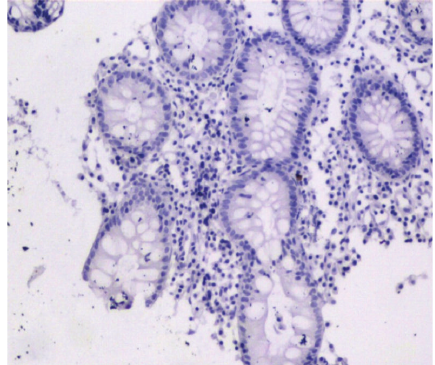
Figure 3: No positive particle (1 × 100).